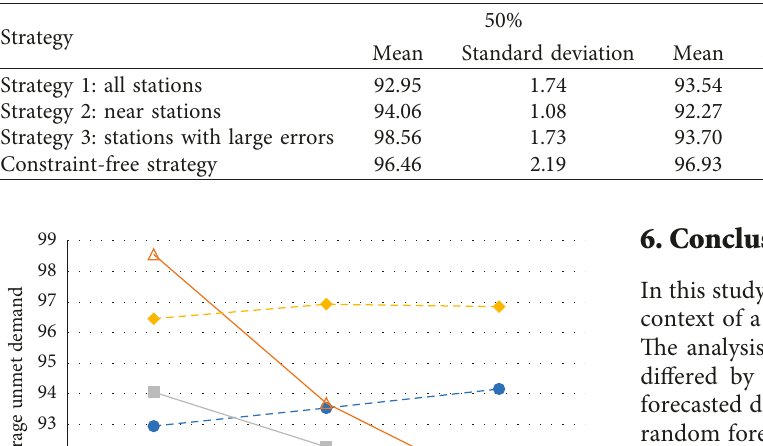
Table 4: Mean and standard deviation by prioritizing strategies.